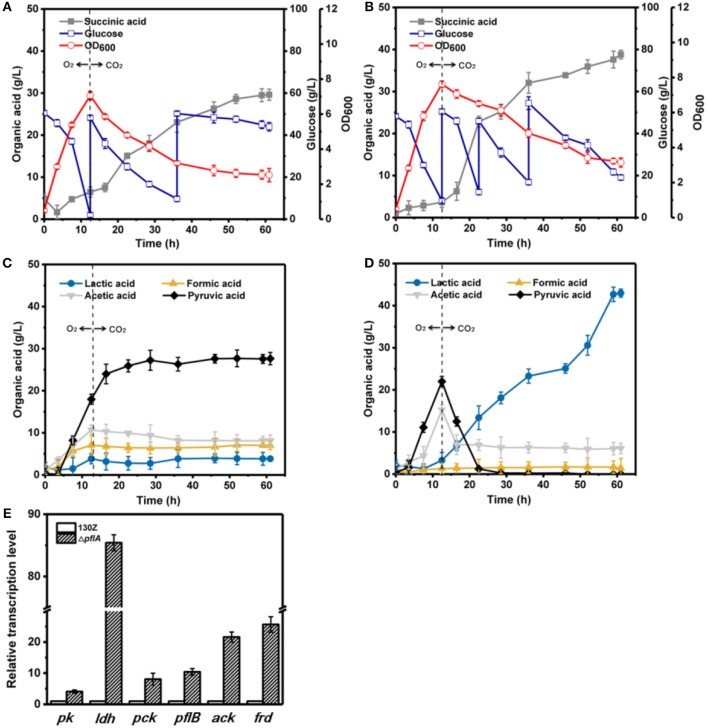
Evaluation of different fermentation and metabolic parameters in the 130Z strain (A,C) compared to those of the ΔpflA strain (B,D) under aerobic–anaerobic dual-phase conditions. The bar graph (E) represents the expression levels of genes related to organic acid biosynthesis pathway.